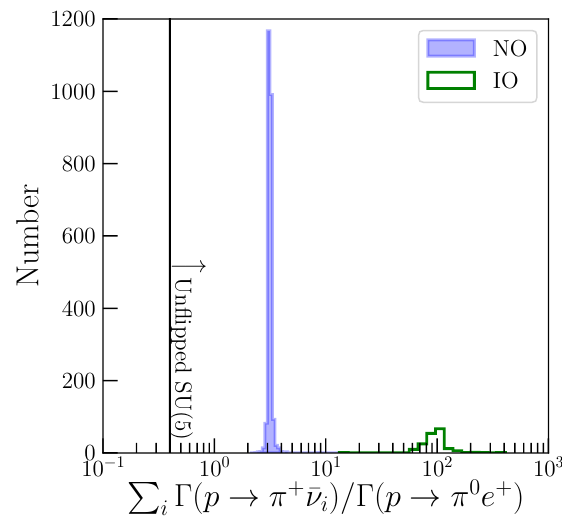
(cid:0)( p (cid:25) + (cid:22) (cid:23) i ) = (cid:0)( p (cid:25) 0 e + ) in (cid:13)ipped SU(5) for the NO and IO cases i ! ! P